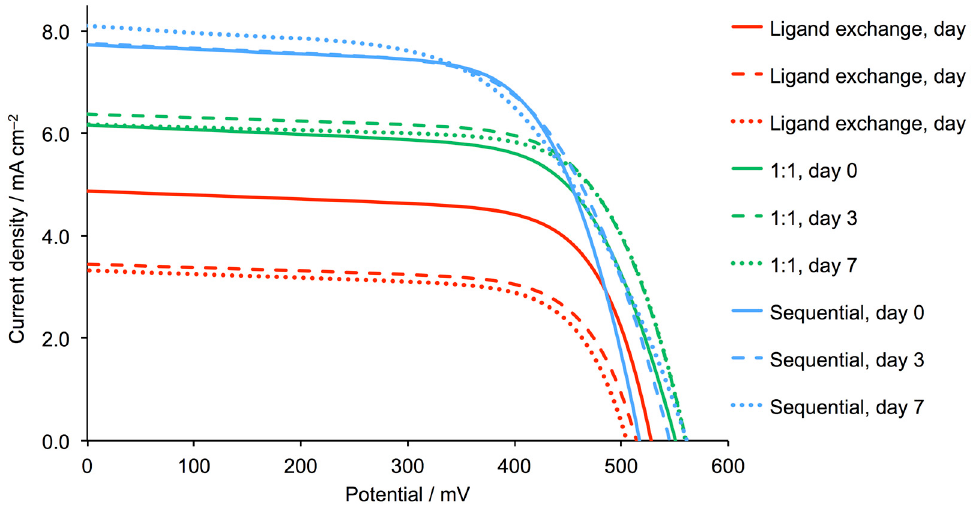
Figure 9. J–V curves for DSSCs (cell 2 in each case, see Table 3) with photoanodes assembled using the three dipping methods described in the Materials and Methods section.